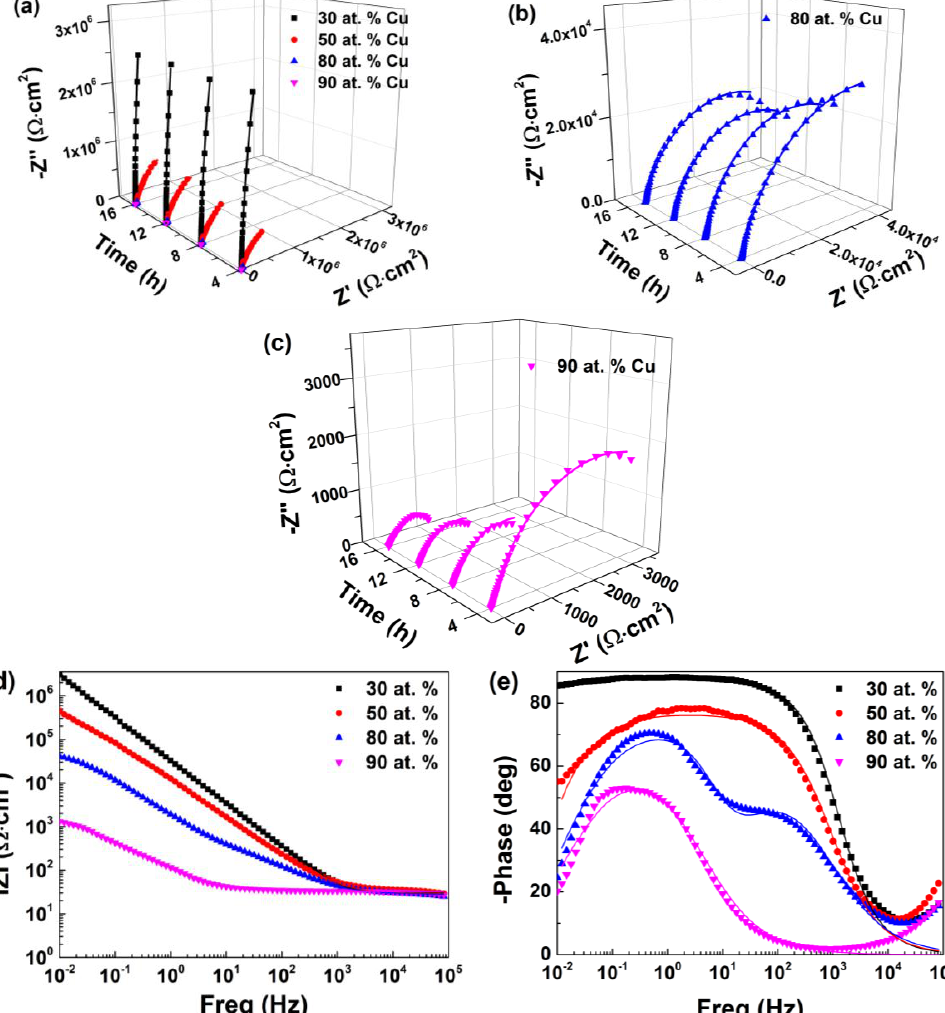
Figure 4. Electrochemical impedance spectroscopy (EIS) of Zr-Cu glassy coatings in 0.01 M deaerated H 2 SO 4 solution at ambient temperature with different immersion time; ( a ) Nyquist plots of coatings’ Cu; ( b ) magnified Nyquist diagram of Zr-80 at.% Cu glassy coatings; ( a , c ) magnified Nyquist diagram of Zr-90 at.% Cu; ( a , d , e ) Bode plots of coatings at 16 h; the solid line represents the fitting curve.